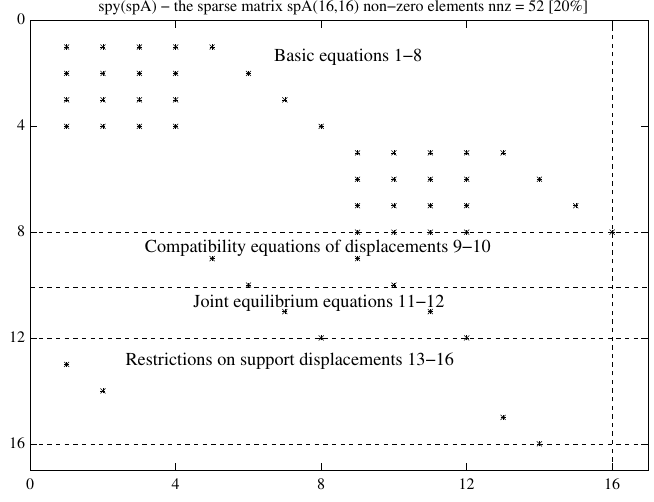
Fig. 8. Sparsity pattern of matrix spA of the fixed-fixed beam.